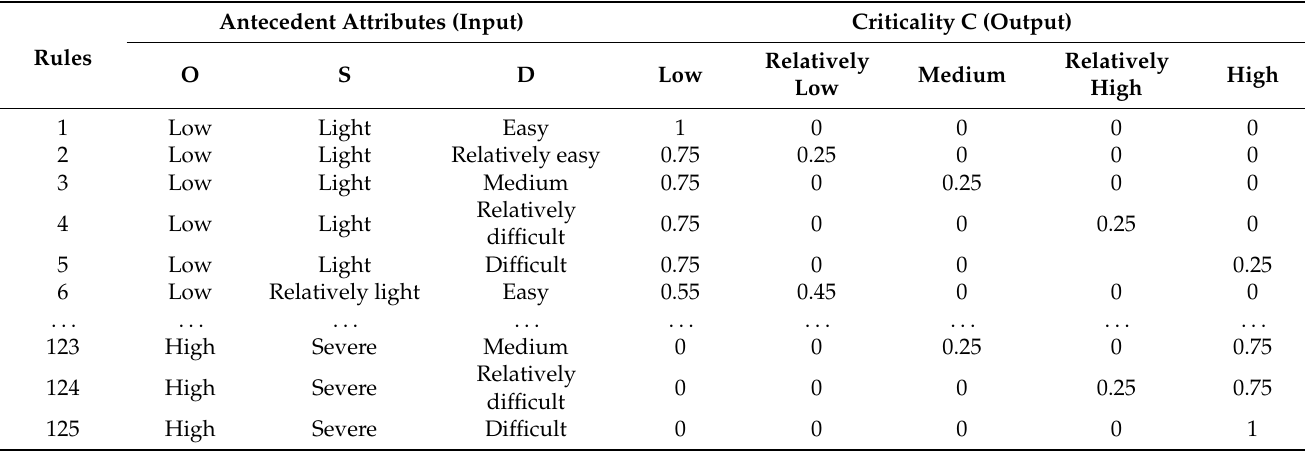
Table 9. Fuzzy rule base based on confidence structure.